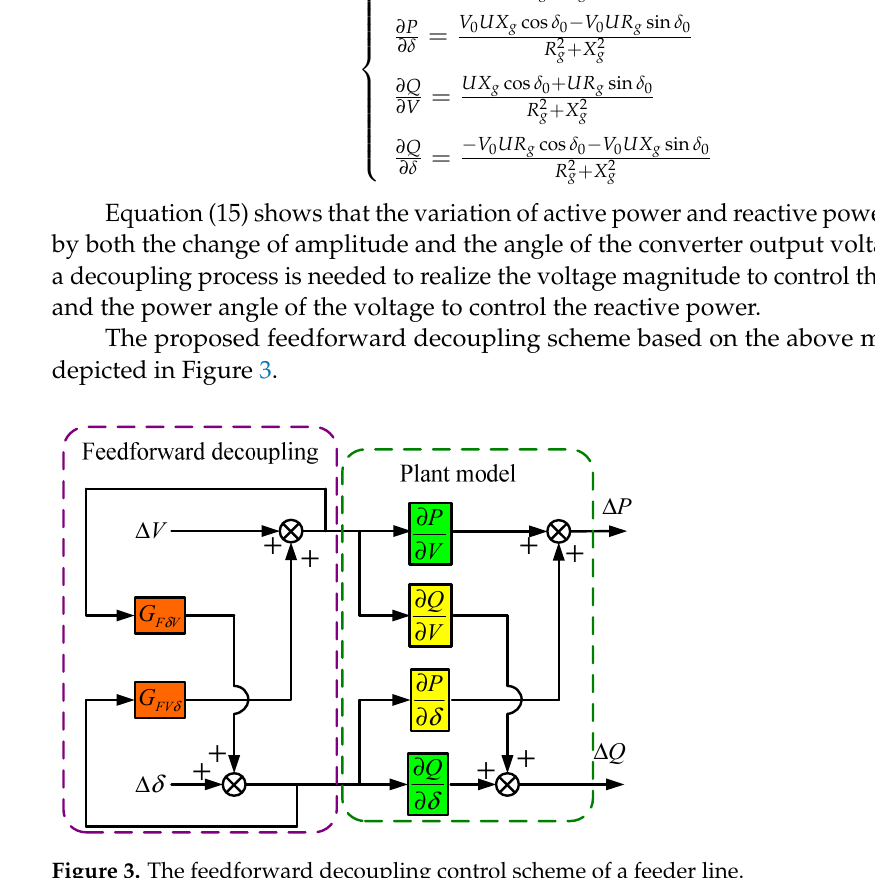
Figure 3. The feedforward decoupling control scheme of a feeder line.